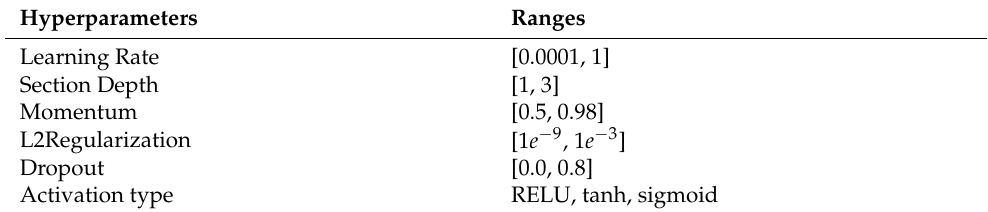
Table 2. Ranges of hyperparameters for